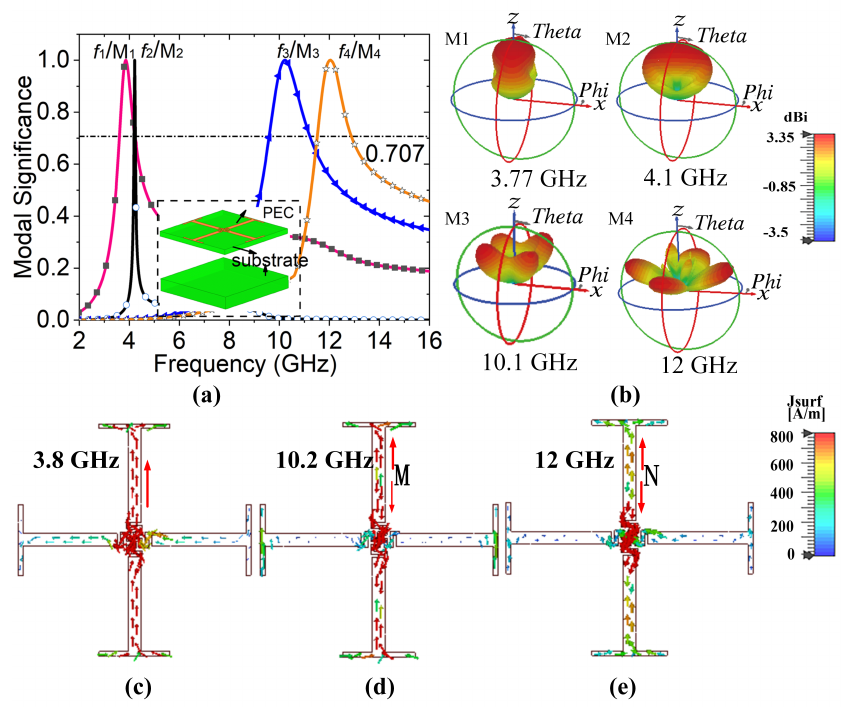
Figure 2. Characteristic mode analysis for the designed absorption structure. ( a ) Modal significance without R. ( b ) Modal radiation patterns. ( c ) Mode current at 3.8 GHz; ( d ) mode current at 10.2 GHz; ( e ) mode current at 12.0